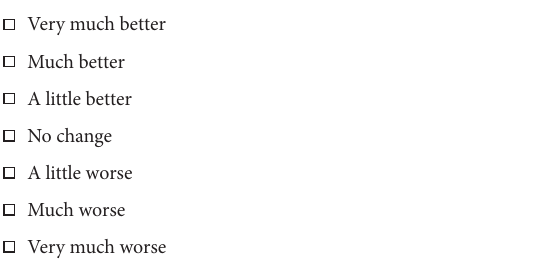
Figure 2: PGI-I Scale used to evaluate patients’ impression of improvement.